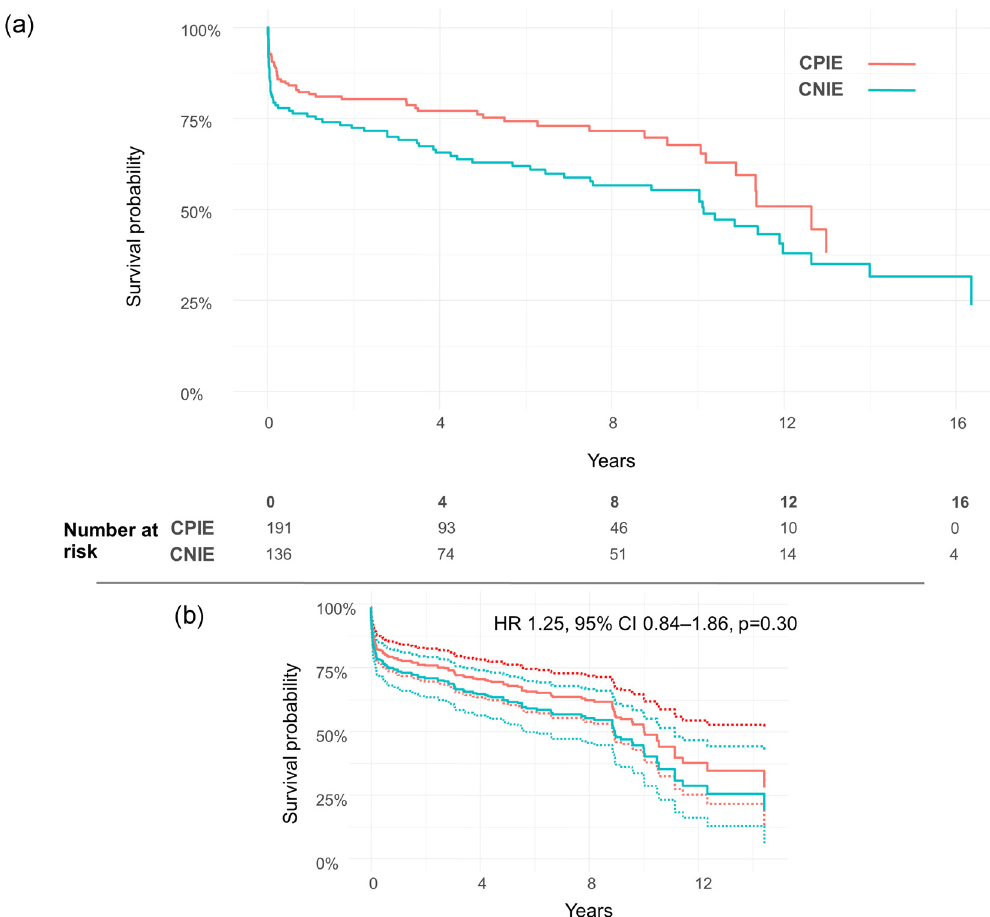
Figure 2: ( a ) Kaplan – Meier survival curves strati fi ed for CPIE and CNIE; ( b ) adjusted survival